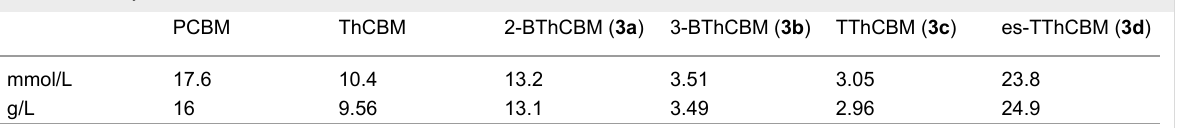
Table 2: Solubility of methanofullerenes a .